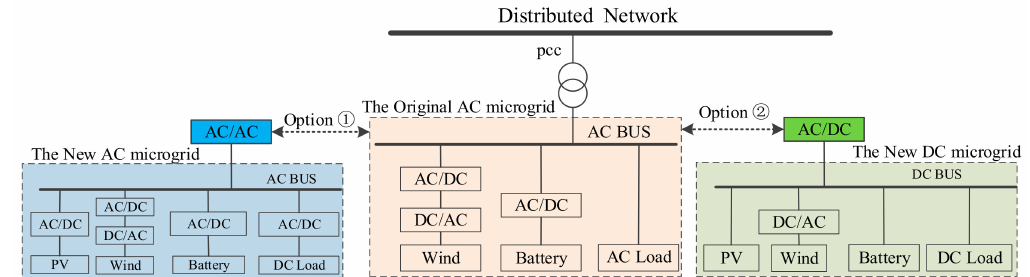
Figure 1. Expansion planning of